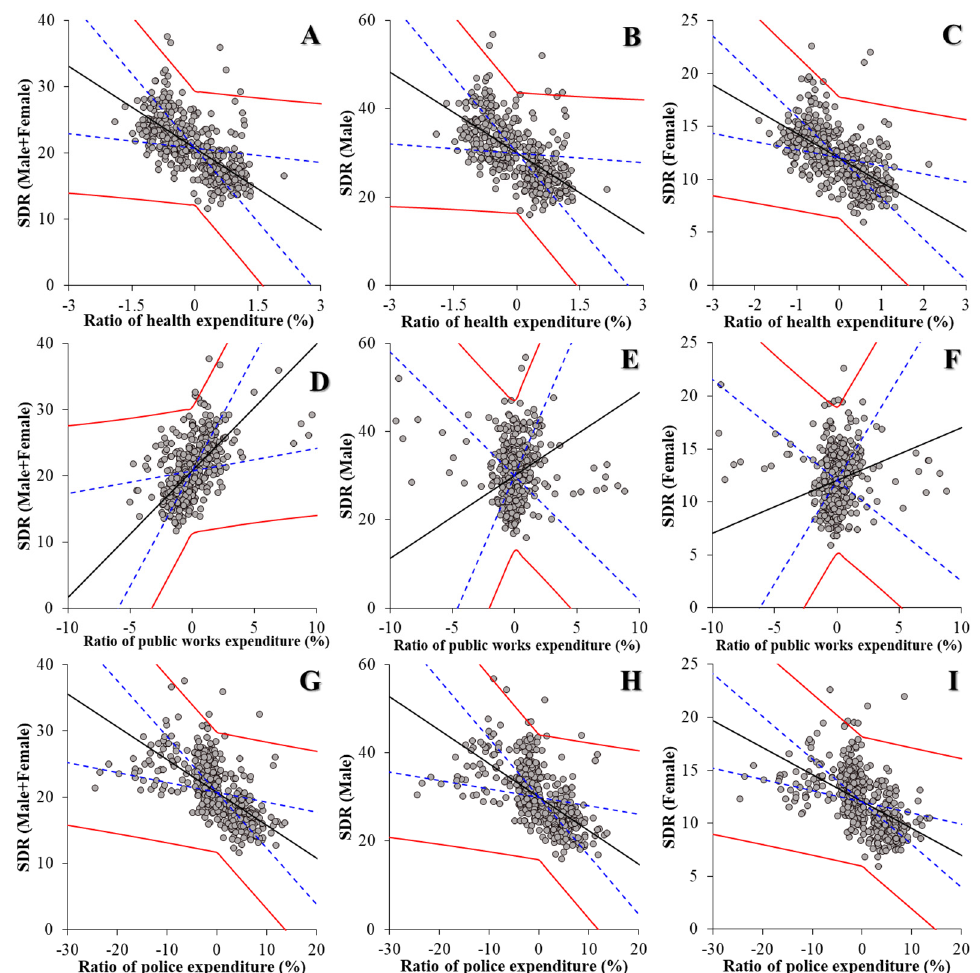
Figure 3. Effects of financial expenditure ratio of public health ( A – C ), public works ( D – F ), and police ( G – I ) of prefectures and municipalities on suicide mortality of males and females together ( A , D , G ), males ( B , E , H ), and females ( C , F , I ) in 2009–2018 using fixed- or random-effect analysis of hierarchal linear regression with robust standard error. Ordinates and abscissas, SDR of suicide mortality (per 100,000 population) and centralised ratios of expenditure per capita of prefectures and municipalities (JPY 10,000), respectively. Black, blue, and red lines, slope of fixed effects, standard deviation of fixed effects, and fixed effects with random effects, respectively. Table 1. Effects of financial expenditure ratio of six divisions of prefectures and municipalities on suicide mortality.